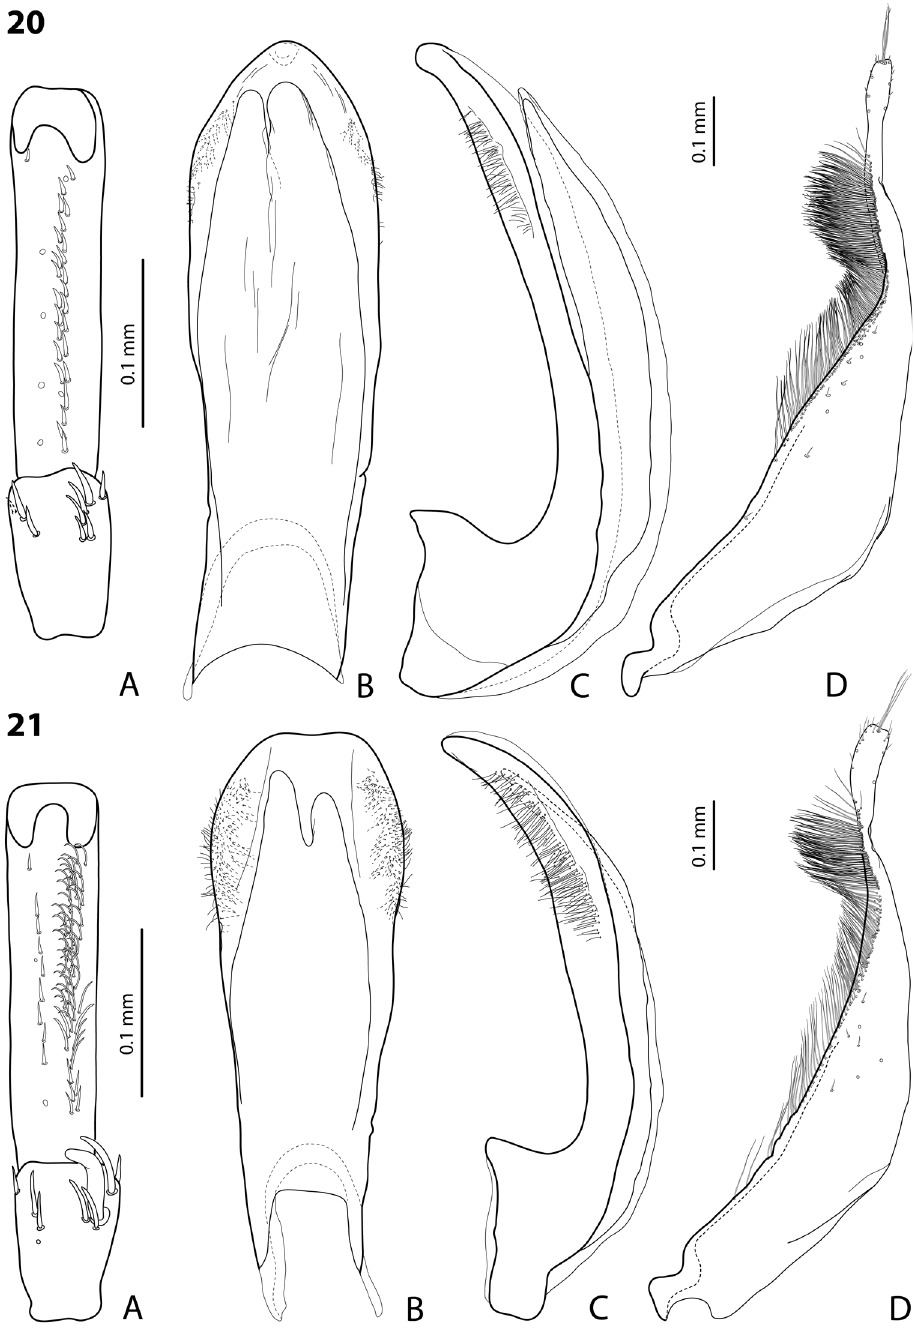
view B median lobe in ventral view C median lobe in lateral view D paramere in external